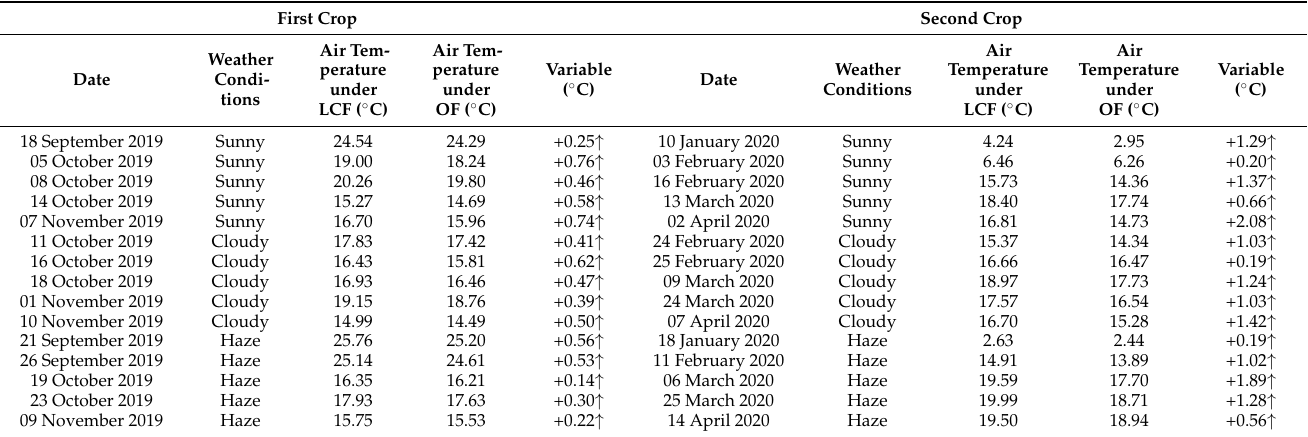
Table 1. Analysis on the effect of different weather on air temperature in light conversion film (LCF) and ordinary film (OF) greenhouse under different